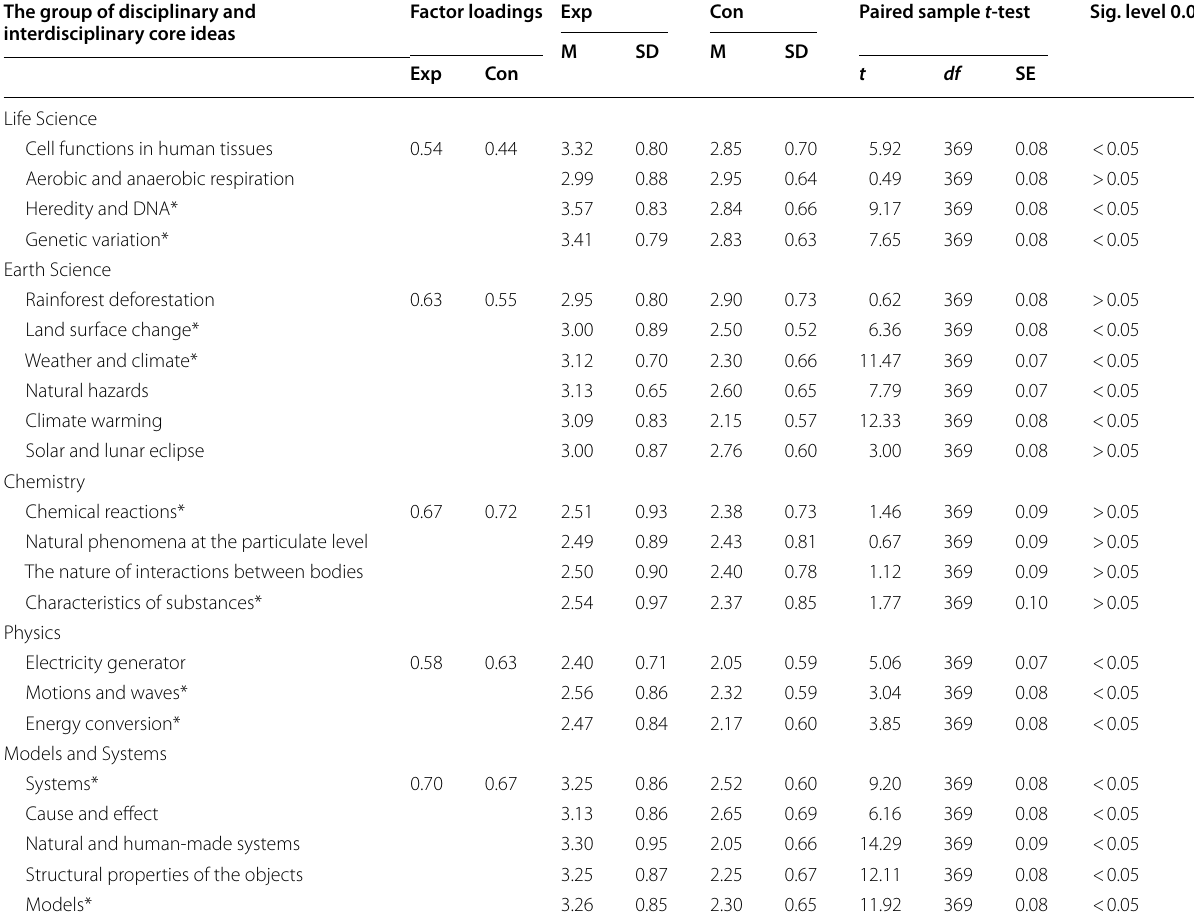
Table 9 Experimental ( N 209) and control group ( N 162) CFA on students’ perceived self-efficacy towards DCIs and ICIs (grade = =